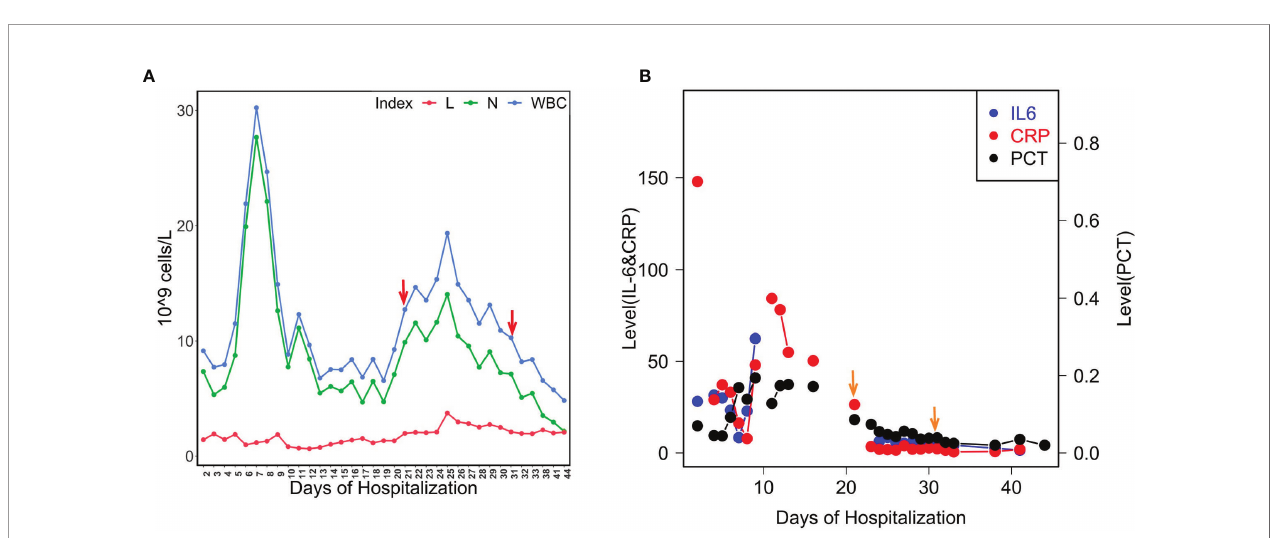
FIGURE 2 | Levels of the patient ’ s blood indices. (A) Counts of WBC, L and N during the course of hospitalization. The isolates were found over the period of the second immune peak. Red arrows indicate the isolation times of LYSZa7(day 21) and LYSZa8(day 31) ; (B) Levels of IL-6 (pg/ml), CRP (mg/L), and PCT (ng/ml) during the course of hospitalization. Orange arrows indicate the isolation times of LYSZa7(day 21) and LYSZa8(day